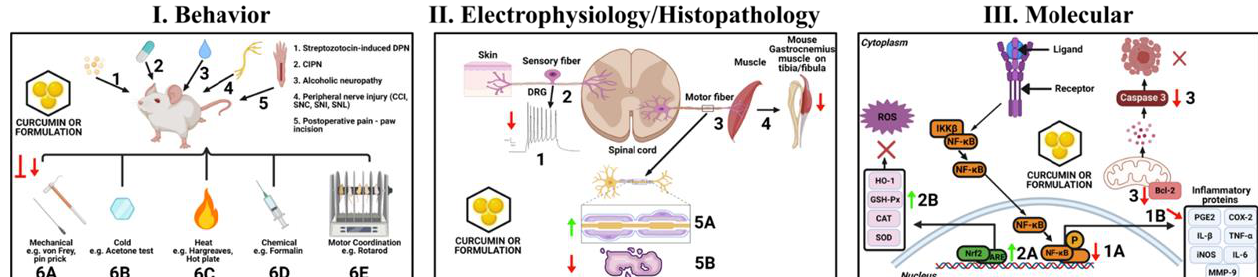
Figure 4. Effects on curcumin or its formulations at the behavior, electrophysiology/histopathology, and molecular levels in peripheral neuropathic and postoperative pain. I. Behavior: Curcumin or its formulations inhibit or reduce DPN (1), CIPN (2), alcoholic neuropathy (3), different peripheral injuries, such as CCI, SNC, SNI, SNL, etc., and/or postoperative pain-induced behaviors in rodent models. Curcumin and its formulations mainly inhibit or reduce mechanical (6A), cold (6B), heat (6C), and chemical-induced (6D) pain behaviors, as well as motor deficits (6E). II. Electrophysiology/Histopathology: Curcumin or its formulations protect injured DRG, decrease neuronal excitability in DRG (1), resulting in attenuation of painful neuropathic behavior. Curcumin or its formulations increase SNCV, decrease loss of DRG neurons, and increase diameter of nerve fibers (2). Furthermore, curcumin and its formulations increase MNCV, decrease neurogenic lesions (3), and atrophy of gastrocnemius muscle (4). The treatments also effectively increase myelin sheath thickness (5A) and prevent demyelination (5B). III. Molecular: Curcumin or its formulations decrease expression of NF- κ B, leading to decrease in inflammatory proteins. Furthermore, the treatments increase expressions of Nrf2, leading to increase in levels of antioxidative enzymes that scavenge free radicals and ultimately reduce ROS levels. Moreover, the treatments decrease expressions of Bcl-2 and caspase-3 that lead to reduction in apoptosis and ultimately improve nerve injuries (created with